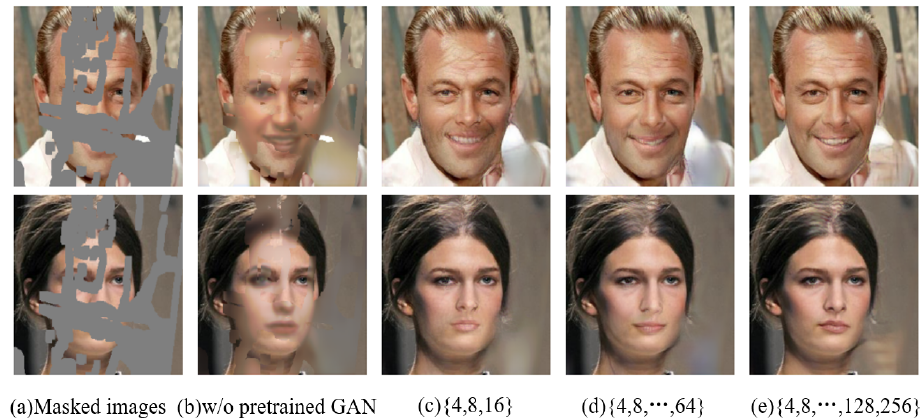
Figure 7. The effect of pre-trained GAN on completion